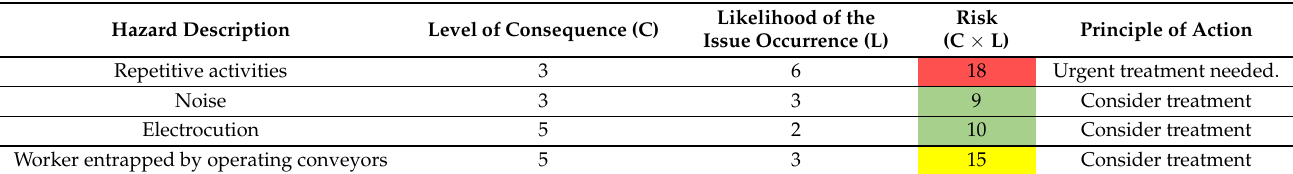
Table 4. Conventional safety risk assessment result.